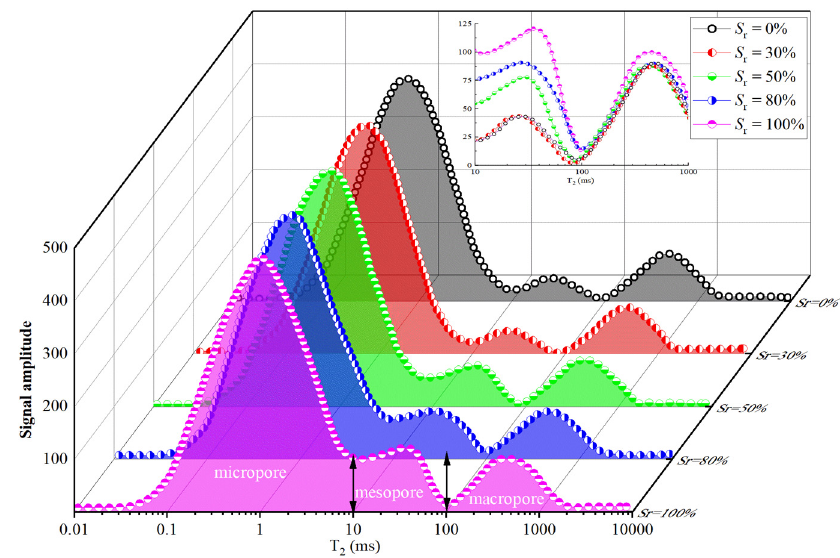
Figure 7. Distribution of the T 2 spectrum of the samples with different saturations.